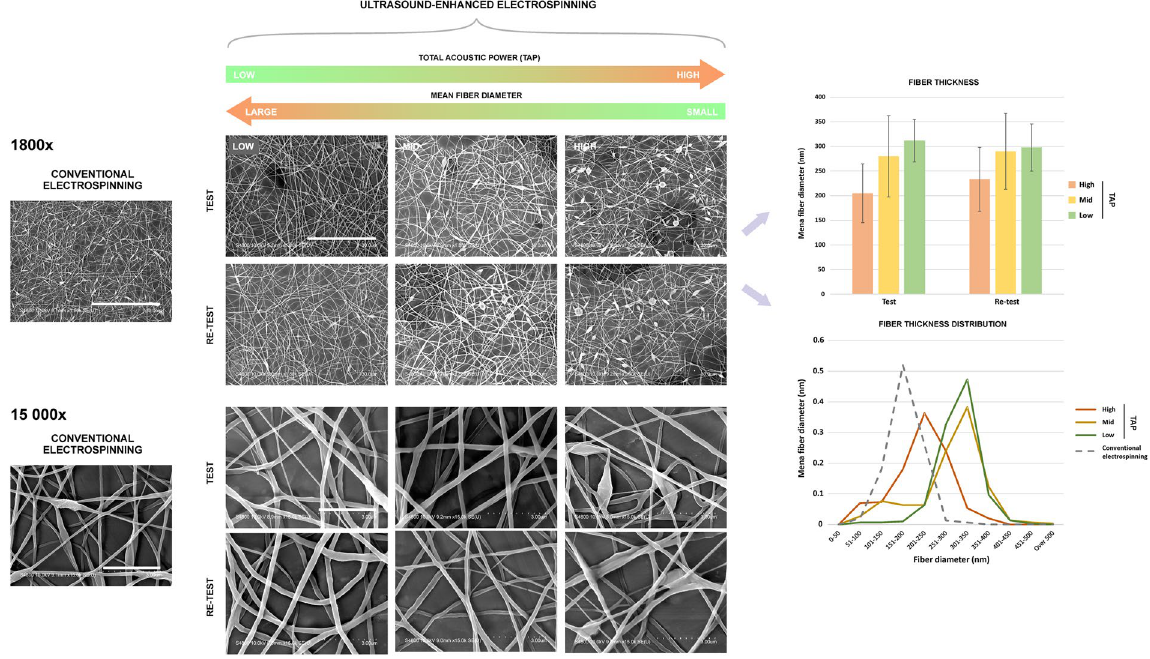
Figure 2. Left and center: Scanning electron microscope images of fibers produced with the ultrasound-enhanced electrospinning (USES) device at low, mid and high ultrasonic power. Top row corresponds to the test and the lower row to a re-test. Low ultrasonic power exhibited fibers with minor “beading”, whereas beading was most pronounced in fibers generated with high ultrasound power and with the reference technique (conventional electrospinning). The images suggest that the visual appearance of fibers was similar in the test compared to the re-test. Ultrasonically enhanced fibers appear thicker than those produced with the reference method. The results suggest that the appearance of the topography of fibers generated with USES can be repeatedly modified. Right: Distribution of fiber diameters produced at high, mid or low ultrasound power in test/re-test -experiments. All methods produced nanofibers with 50–500 nm diameter. Ultrasound-enhanced fibers were qualitatively thicker and statistically different in diameter ( p < 0.0001) than those produced with the reference method. The fibers produced using high ultrasound power were qualitatively thinner and statistically significantly different ( p < 0.0001) than those produced with ‘mid’ or ‘low’ ultrasound power. The ‘mid’ ultrasound exposure produced a narrower fiber distribution than the low power, but low power produce thinner fibers in the 50–200 nm range. The results suggest that the distribution in fiber diameter can be modified by changing the ultrasound power, without changing the chemical composition of the source polymer. The reference fibers were produced with conventional needle electrospinning. For comparability the area of each histogram was normalized to 1. For statistical analysis, non-parametric Kruskall-Wallis for pairwise comparison with Bonferroni adjustment was used. Scale bars for 1800 × and 15 000 × magnifications corresponds to 30 μ m and 3 μ m,